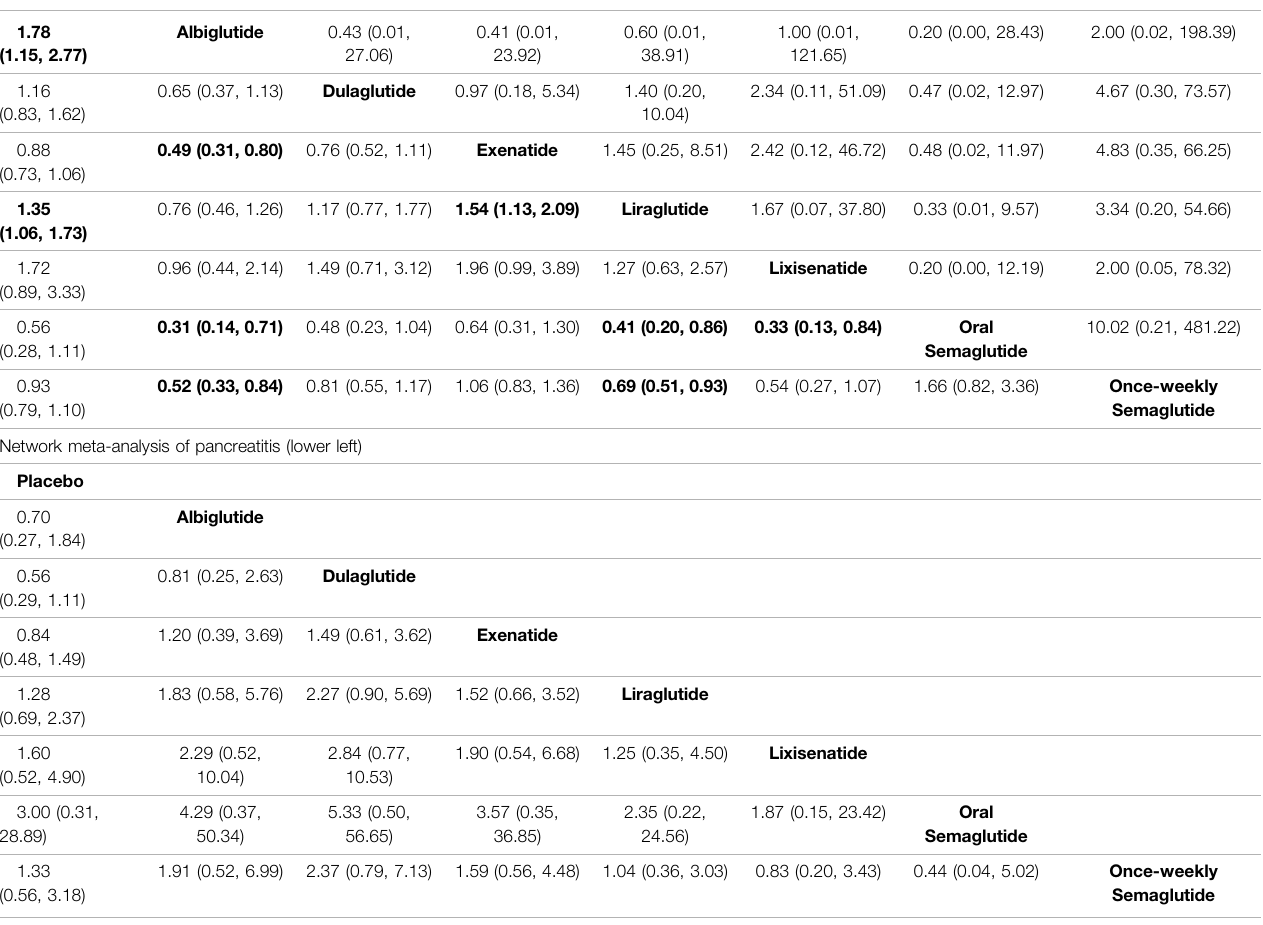
TABLE 2 | ( Continued ) Network meta-analysis of nine primary outcomes.